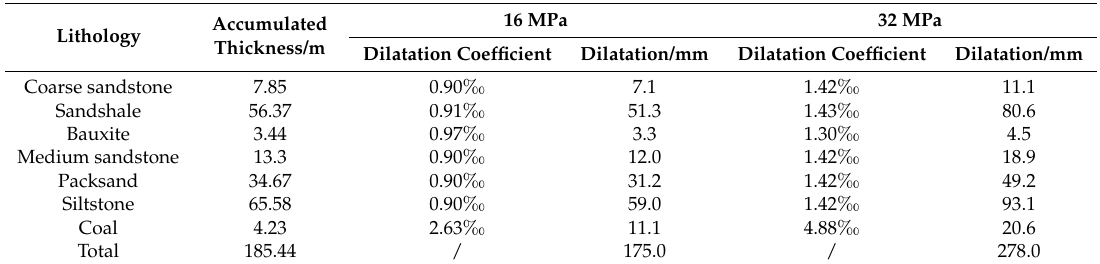
Table 2. Total amount of unloading dilatation with different lithology.